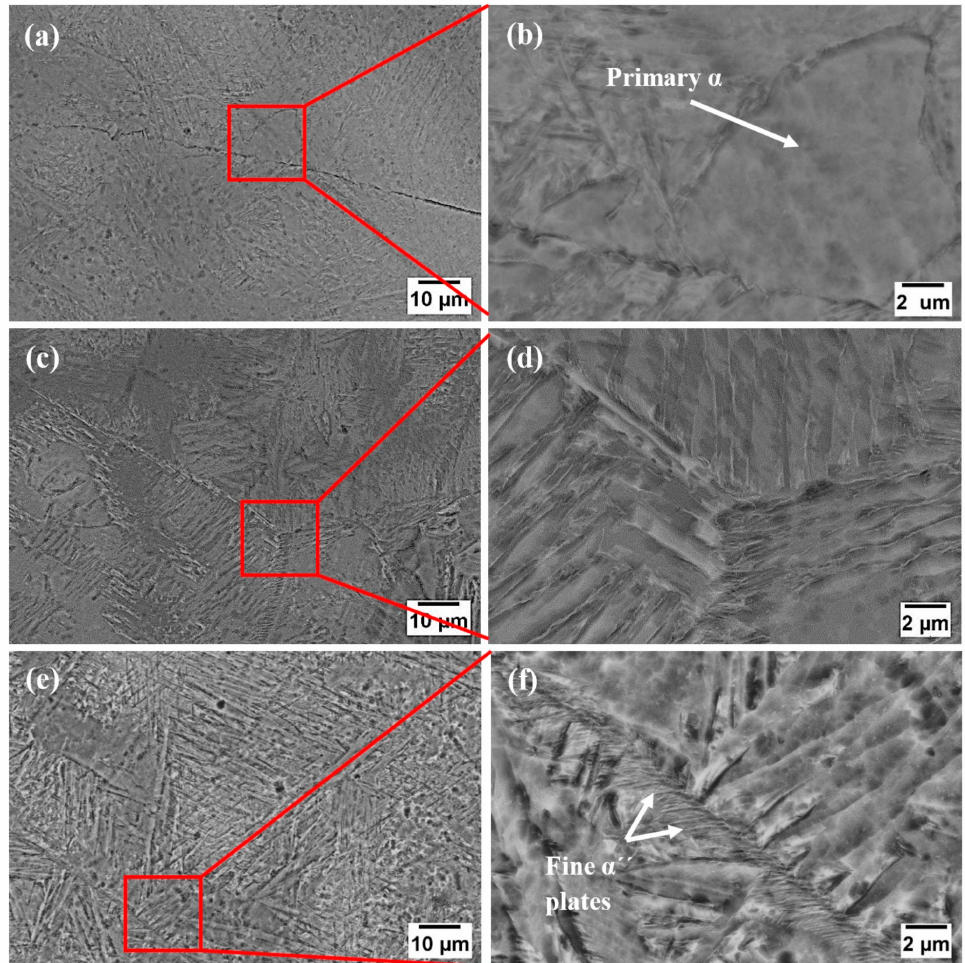
Figure 2. Microstructure of Ti-xTa alloys on SEM—( a , b ) Ti-5%Ta; ( c , d ) Ti-15%Ta; ( e , f )